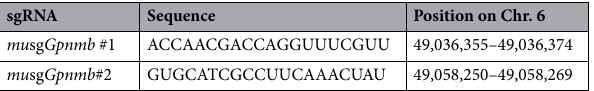
Table 3. sgRNAs used to delete the mouse Gpnmb gene.